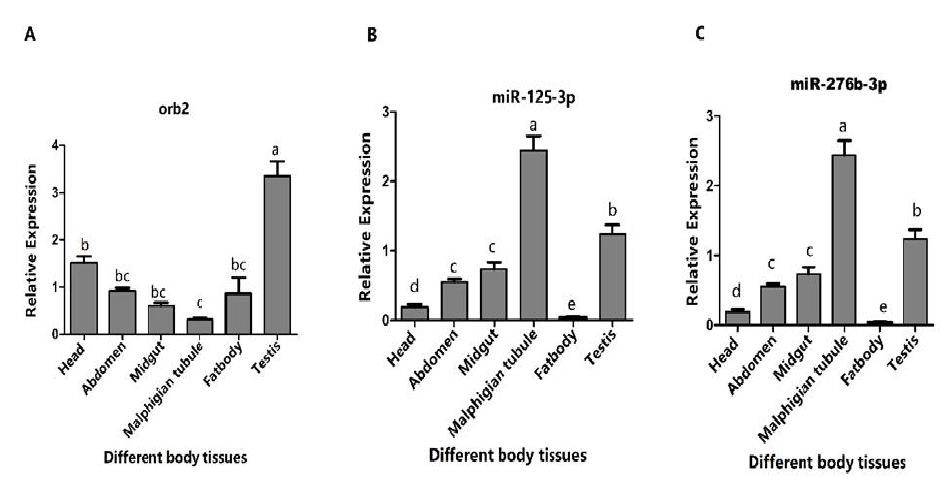
Figure 2. Expression profiles of orb2 and its target miRNAs in different tissues of adult males of B. dorsalis. ( A ) Relative expression of orb2 in different tissues. ( B ) Relative expression of miR-125-3p in different tissues. ( C ) Relative expression of miR-276b-3p in different tissues. Different letters above the bars indicate significant differences (least significant difference in one-way analysis of variance ( p < 0.05).